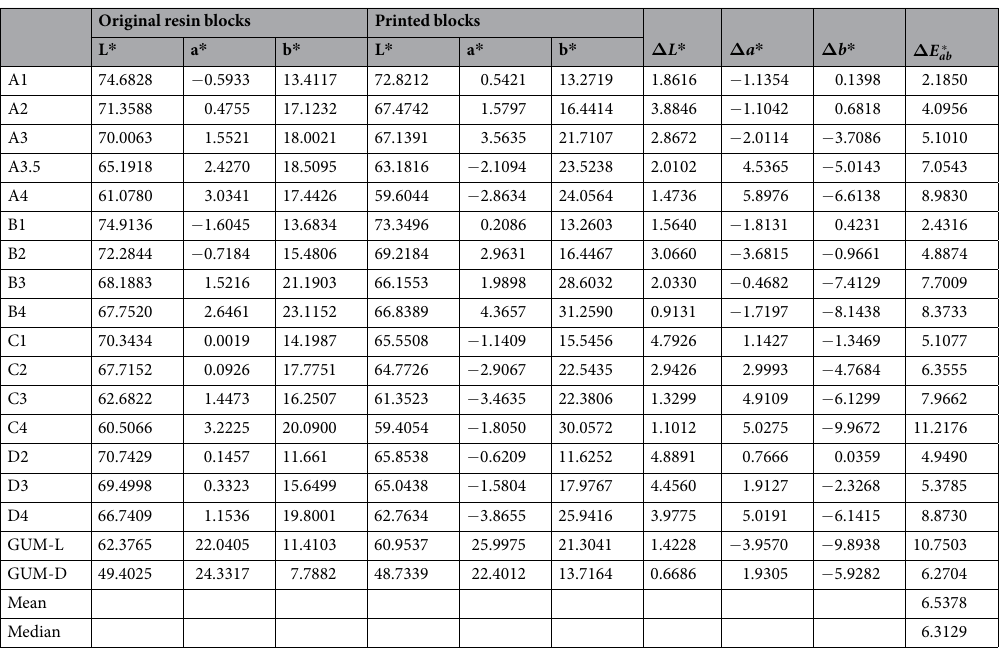
Table 3. CIE L * a * b * values of original and printed tooth and gum shade